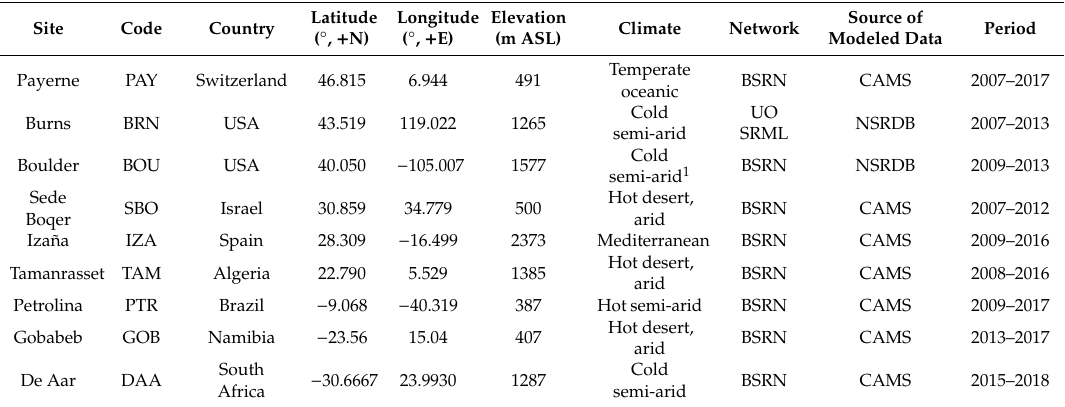
Table 1. Measured and modeled solar radiation database used in this